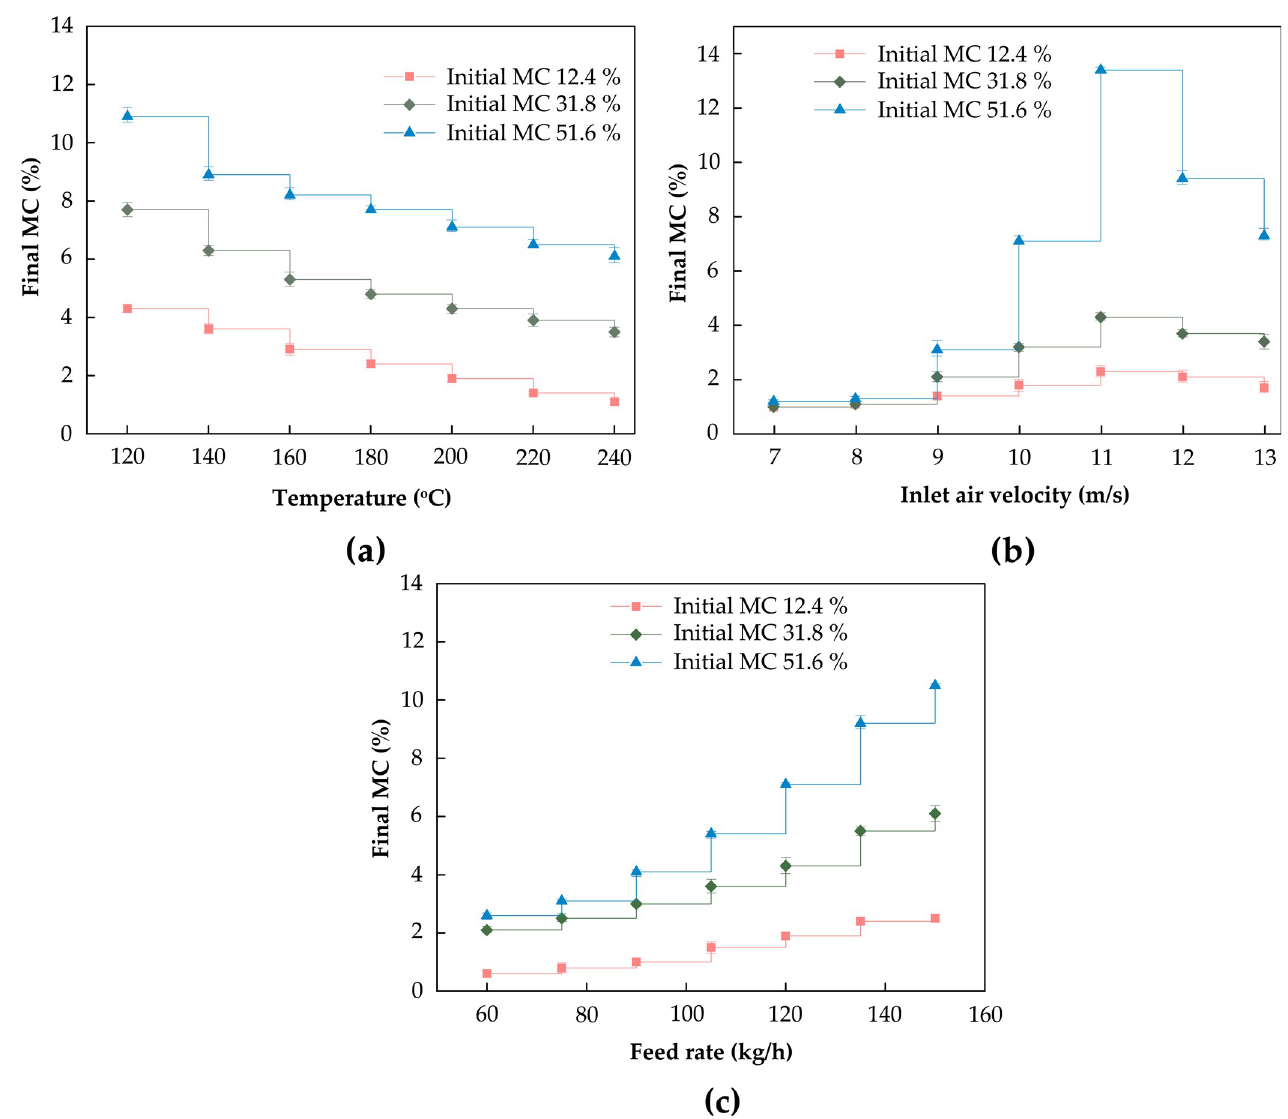
Fig 9. Results of the single factor test, (a) effects of different inlet air temperatures on final moisture content, (b) effects of different inlet air velocities on final moisture content, (c) effects of different feed rates on final moisture content.